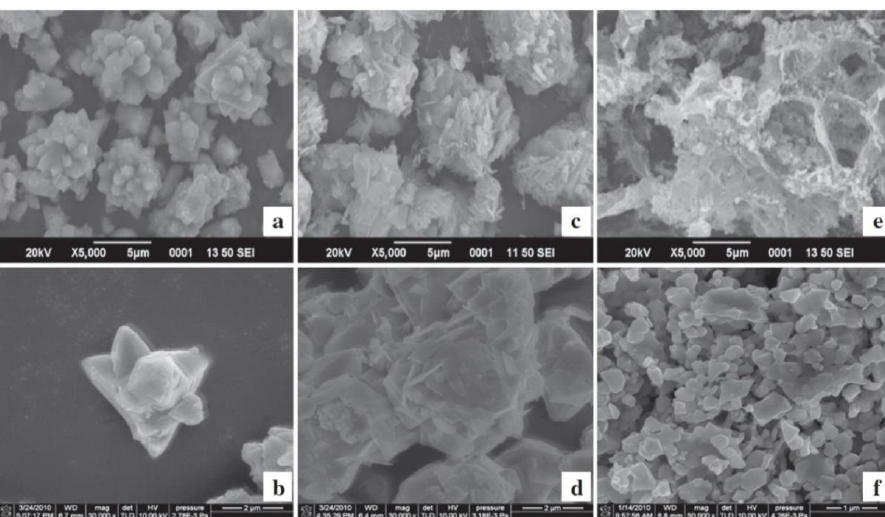
Figure 73. SEM images of ZnO samples with the following molar ratios of urea/Zn 2+ ( a , b ) 1:1, ( c , d ) 5:3, and ( e , f ) 3:1. Products synthesised by the microwave induced combustion process. Reprinted from [847], Copyright (2010), with permission from Elsevier [OR APPLICABLE SOCIETY